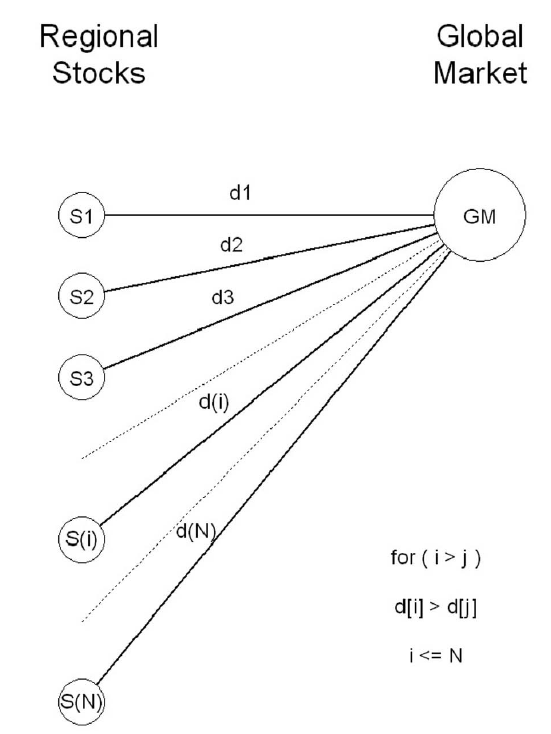
Fig . 1. – Model framework. The N regional fish stocks ( S ) have i identical productivity, and the only significant difference among them is their distance from the globalized market. This distance is translated into larger fishing cost for resources located furthest away from the market. Table 1. – Model parameter values. While they are scaled to real examples, they do not fit to any particular fishery. Biological param- eters are r (intrinsic growth rate), K (carrying capacity), q (catch- ability coefficient). Environmental fluctuations are normally distrib- uted ( μ = mean and σ = standard deviation). Economic parameters are c (cost of fishing), α (maximum price of the marine commodity 0 at t = 0), β (flexibility of price to changes in supply) and γ (yearly increase in demand for marine commodity).